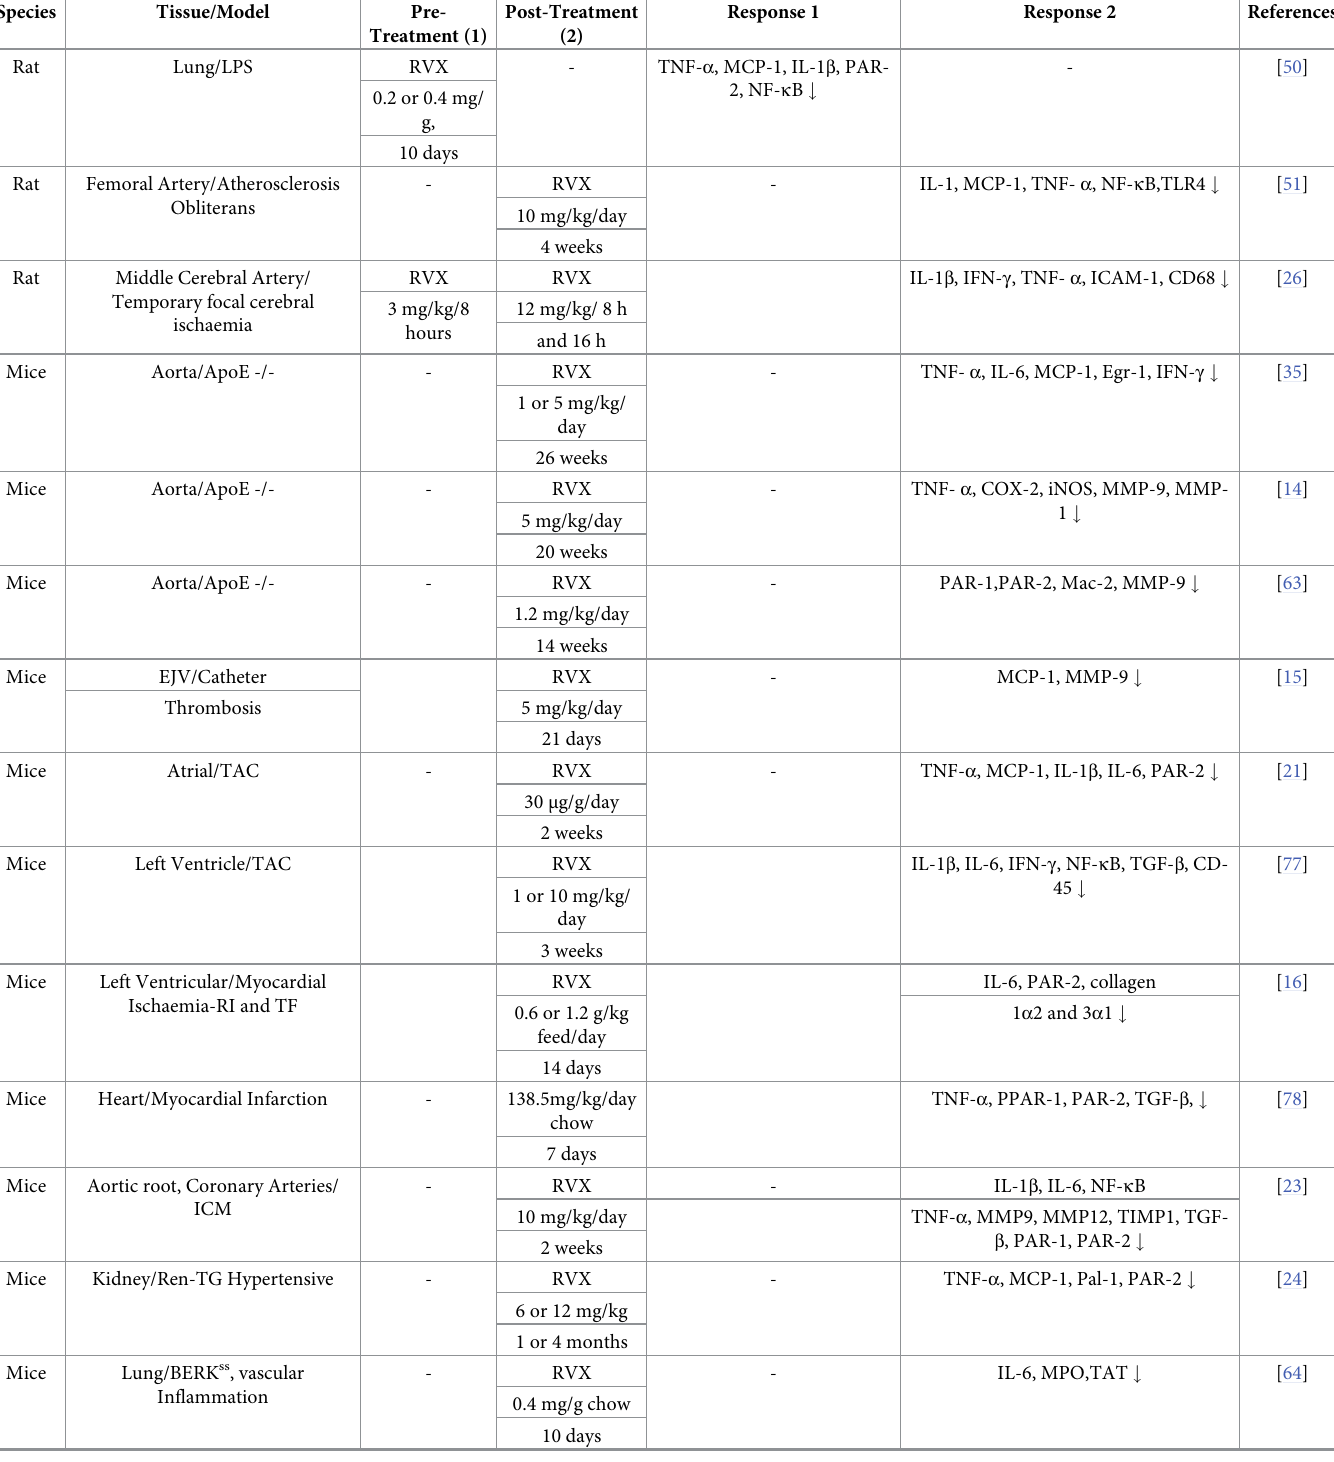
Table 2. Basic experimental studies that investigate the anti-inflammatory properties of pre-treatment and post-treatment with RVX.